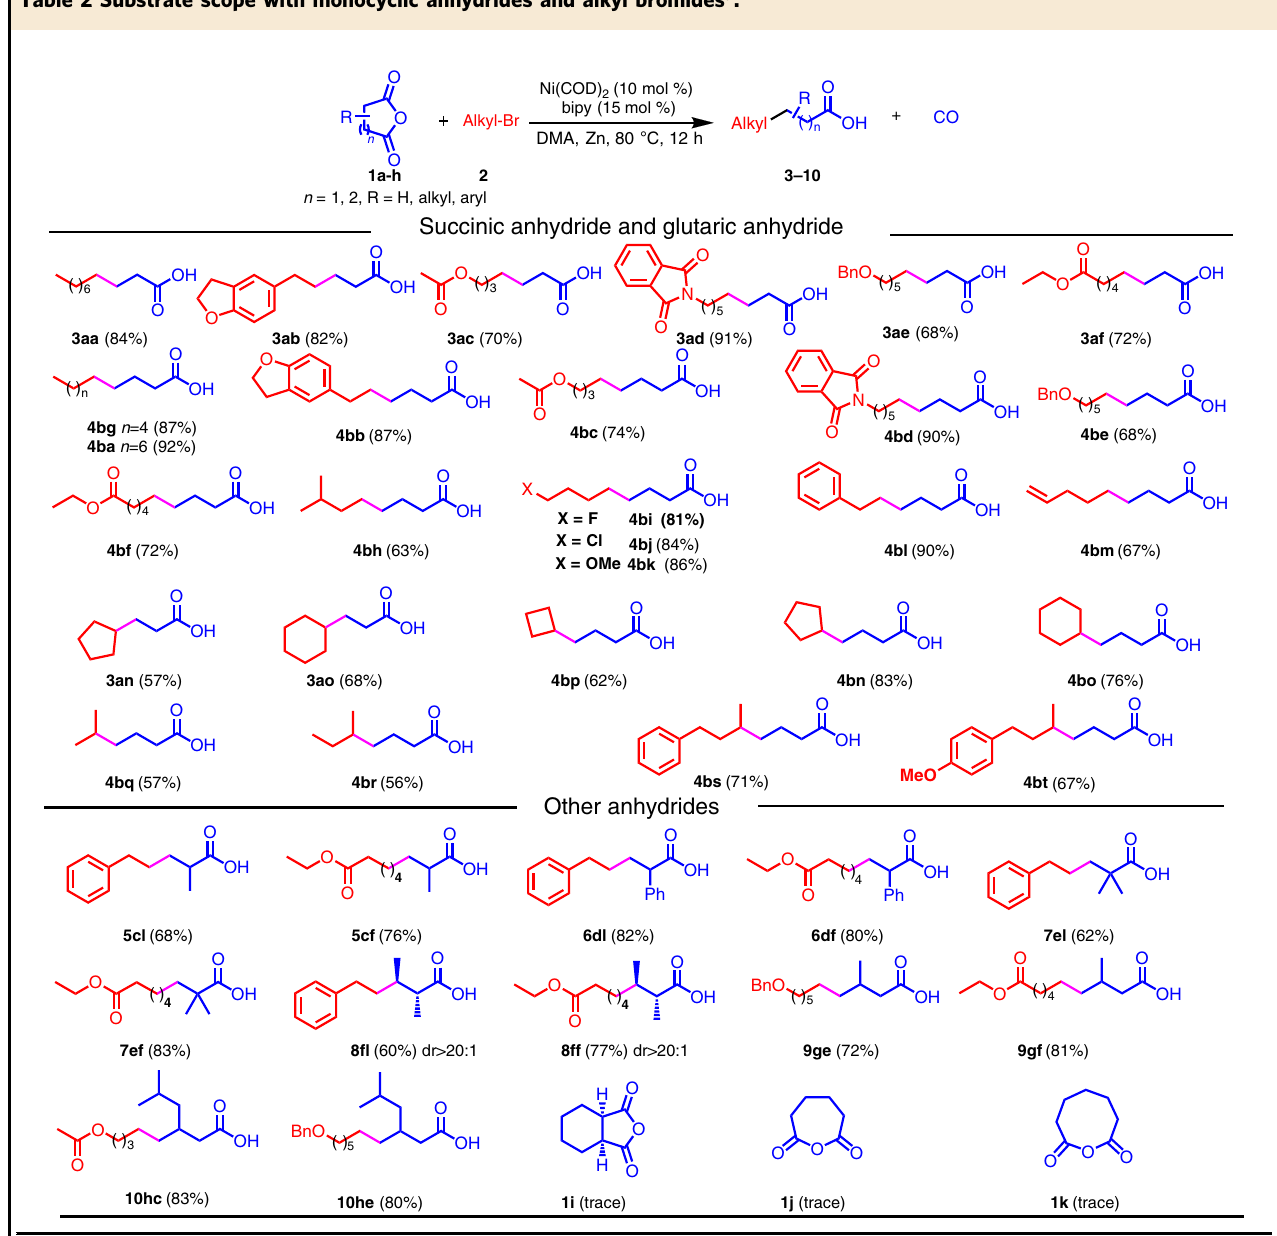
Table 2 Substrate scope with monocyclic anhydrides and alkyl bromides a